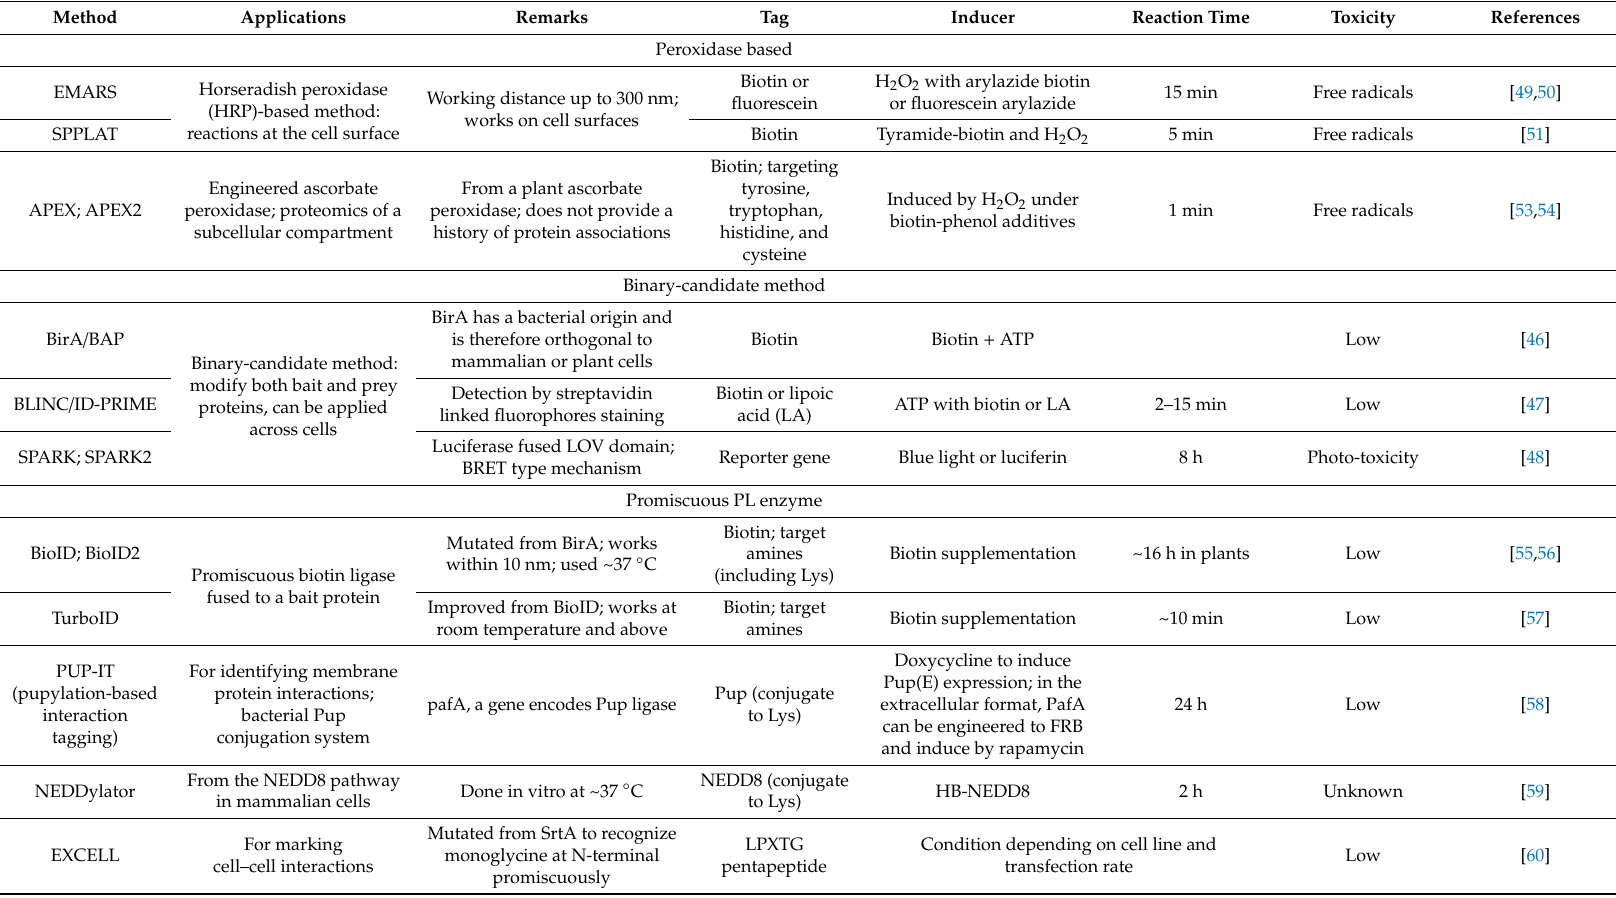
Table 1. Proximity labeling (PL) methods categorized by the enzyme